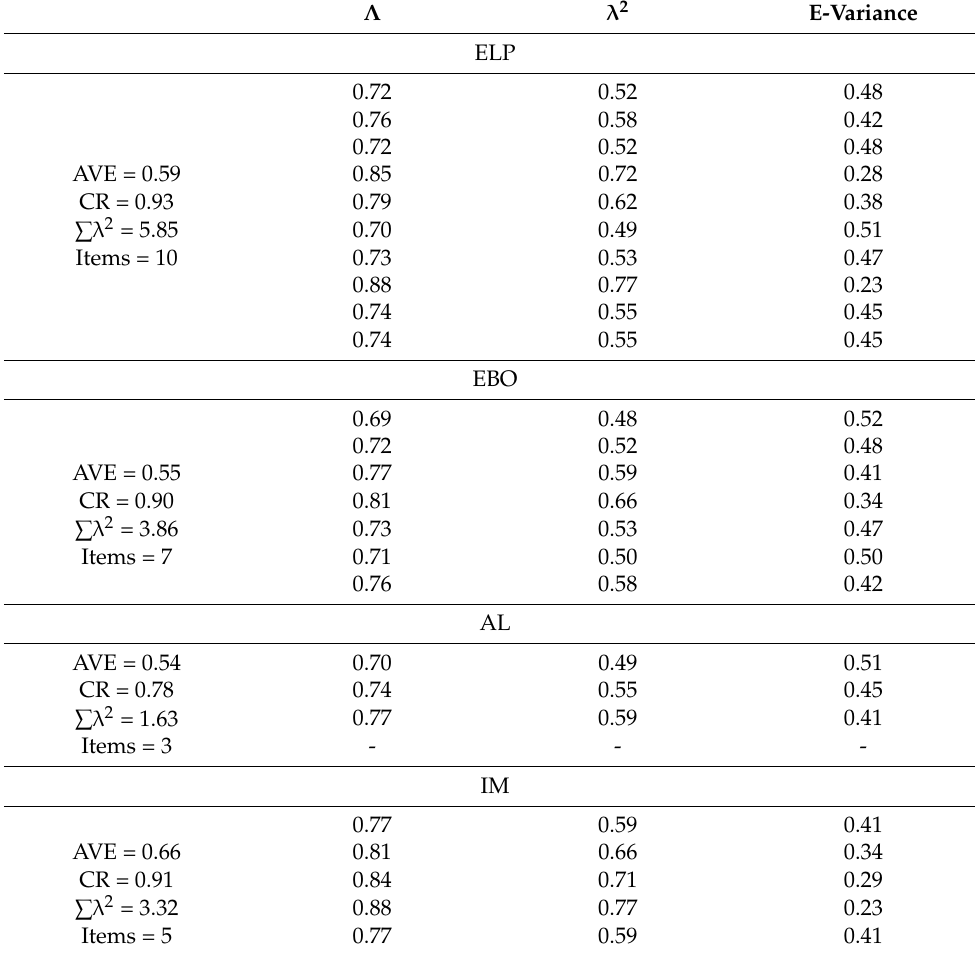
Table 3. Validity and